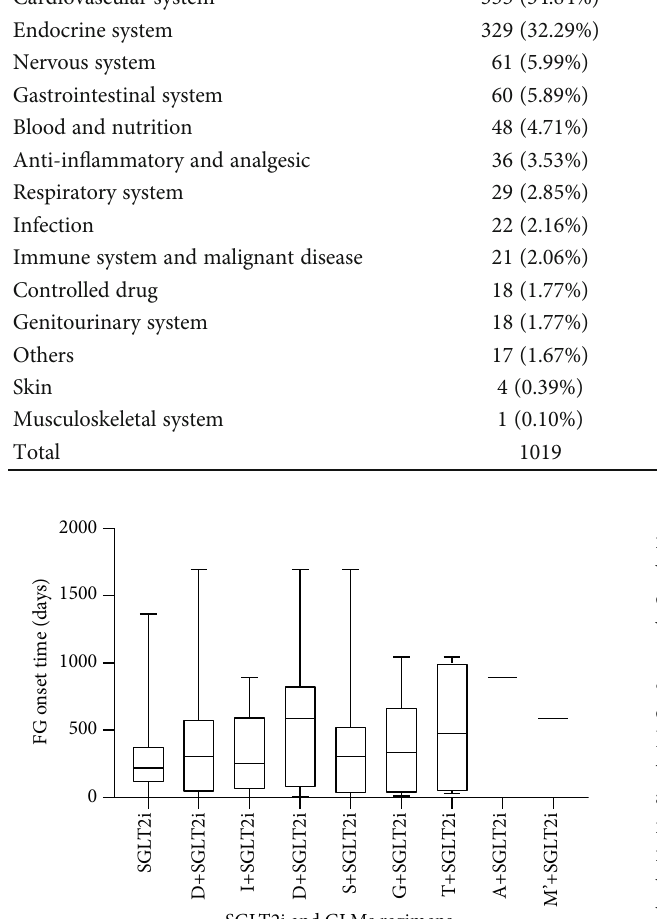
Table 5: All concomitant drugs and concomitant antidiabetic drugs received by FG patients under SGLT2 inhibitor therapy. All concomitant drugs